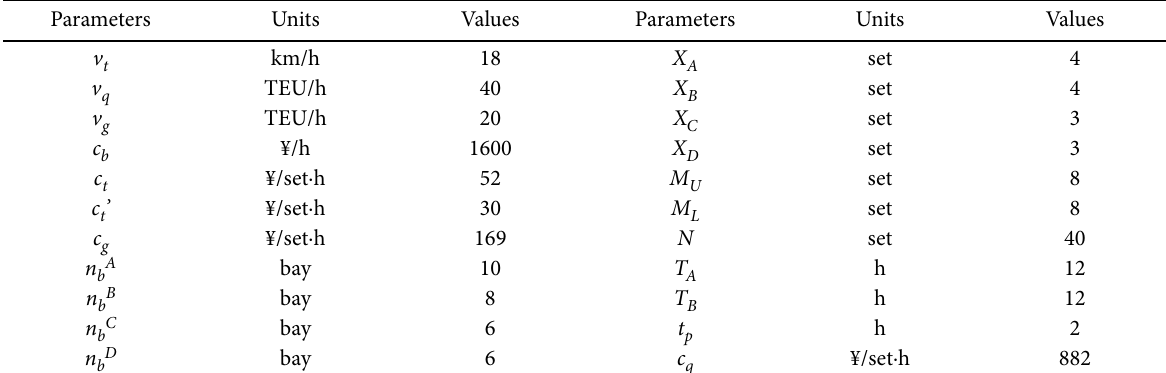
Fig. 7. Layout structure of container terminals Table 1. Related parameter